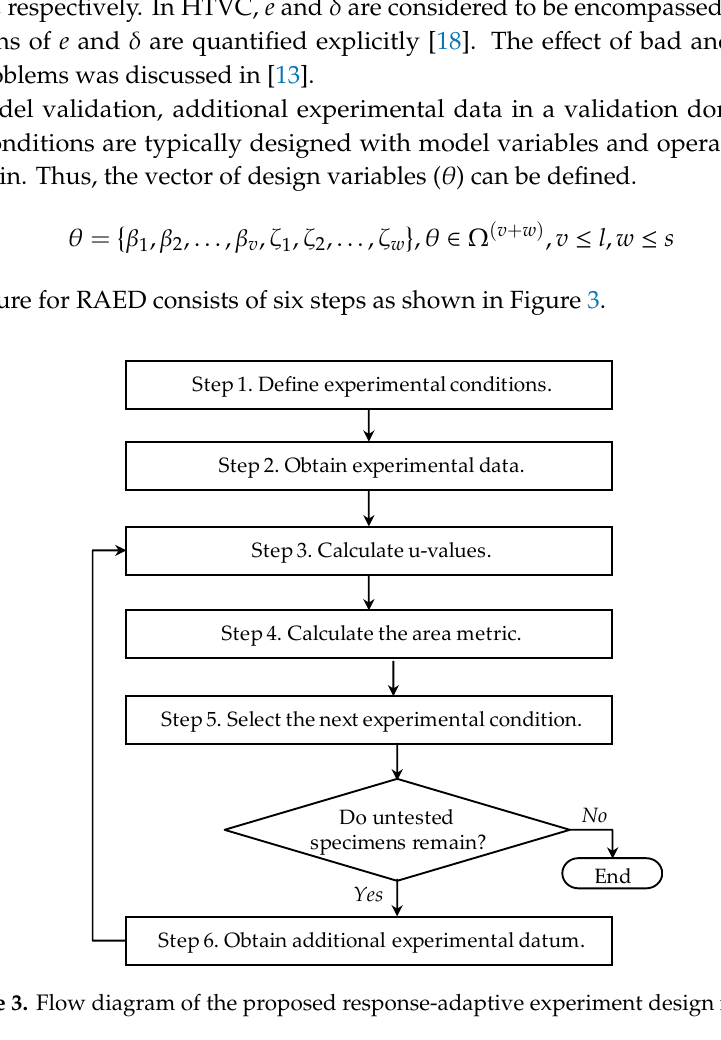
Figure 4. Example of RAED: Two-level factorial design with two design variables. 3.2. Experimental Design for Reduction of Type II Error As explained in Section 3.1, RAED selects the next experimental setting as the condition where the calculated area metric ( U ) is smaller than other conditions. The lower area metric indicates that the predicted PDF is not closer to the mother distribution of the experimental data. In this section, with deductive reasoning, the relation between the low area metric and the reduction of type II error is studied. The type II errors of two hypothetical experimental conditions are compared. It is worth